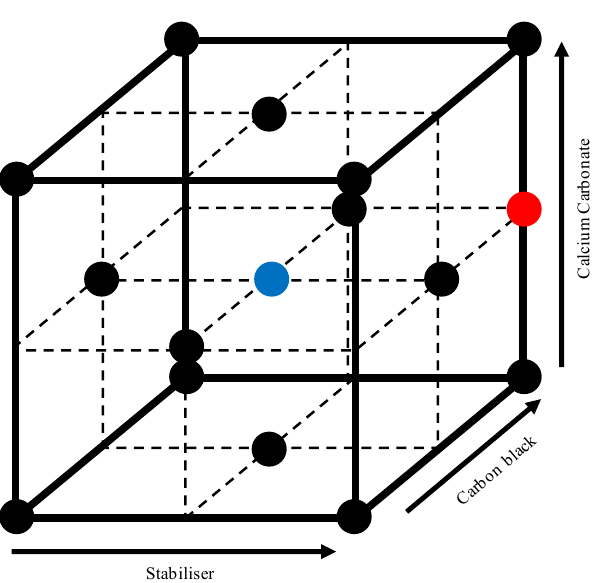
Figure 1. Slack-variable representation of experimental design. The blue dot is the duplicate centroid, while the red dot is the feed-varied duplicate set. Reproduced with permission from Viljoen and Labuschagné, Polymer Testing; published by Elsevier, 2020